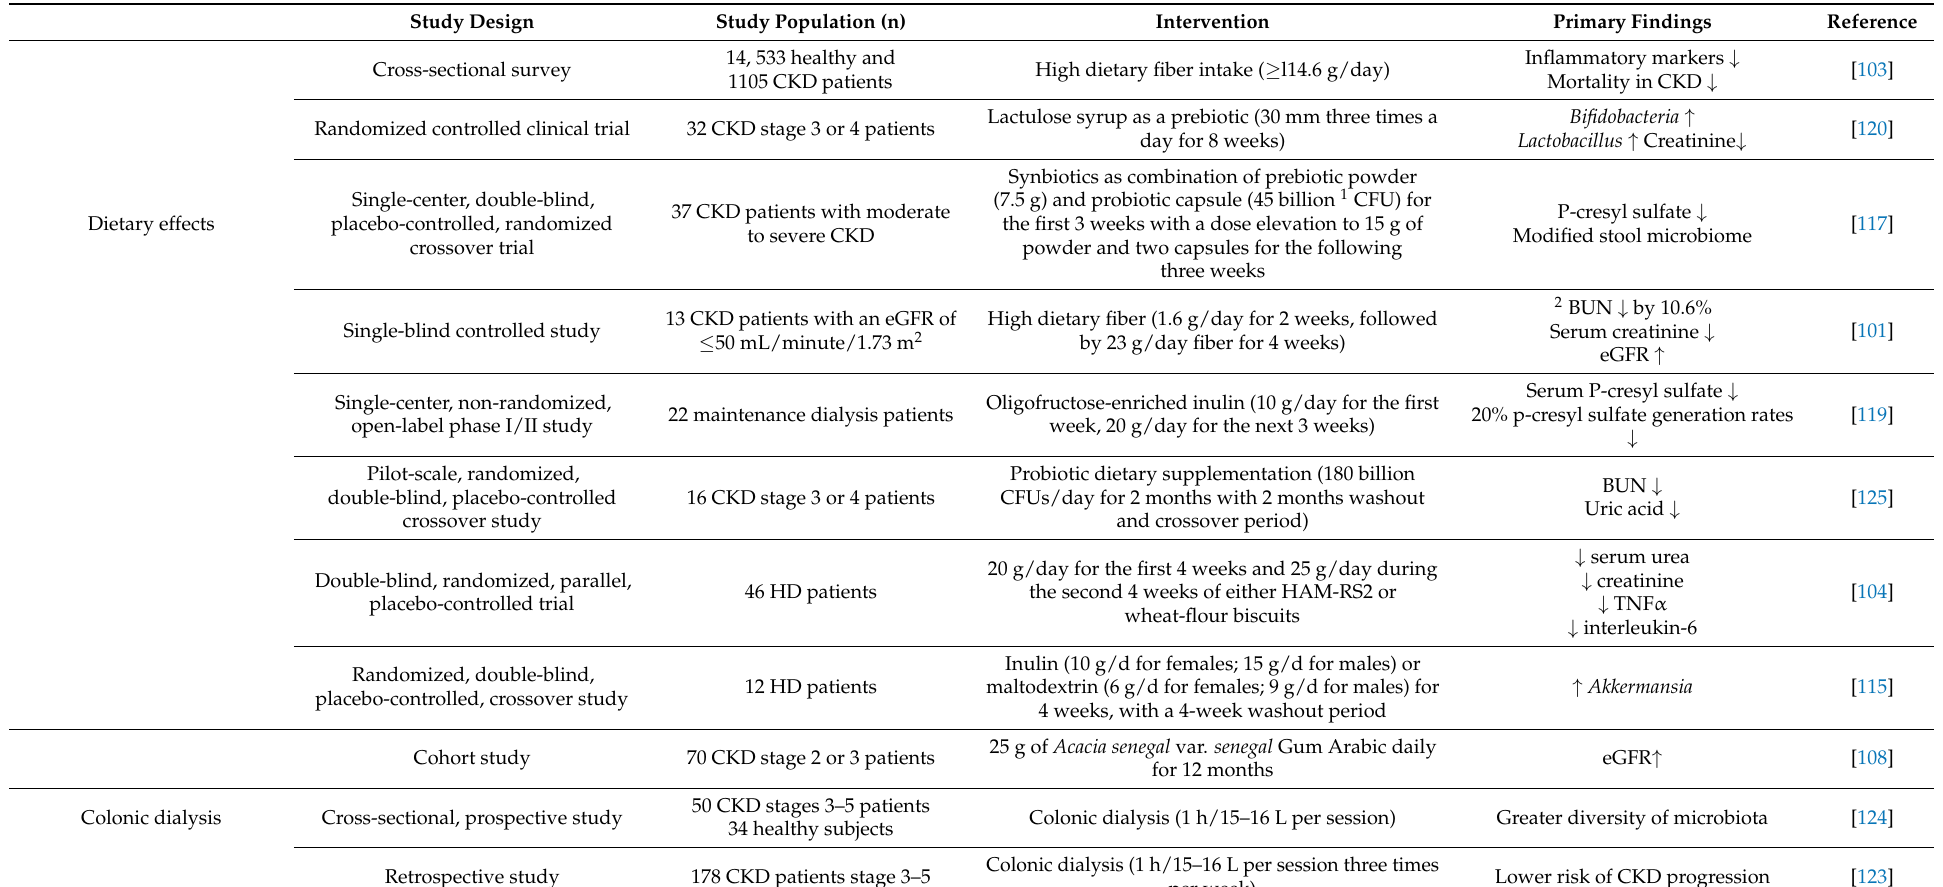
Table 1. Summary of gut targeted intervention strategies and outcomes in CKD